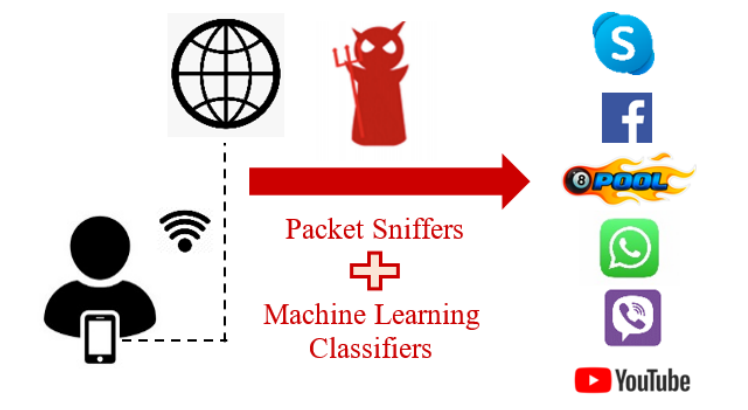
Figure 1. Mobile traffic classification attack.